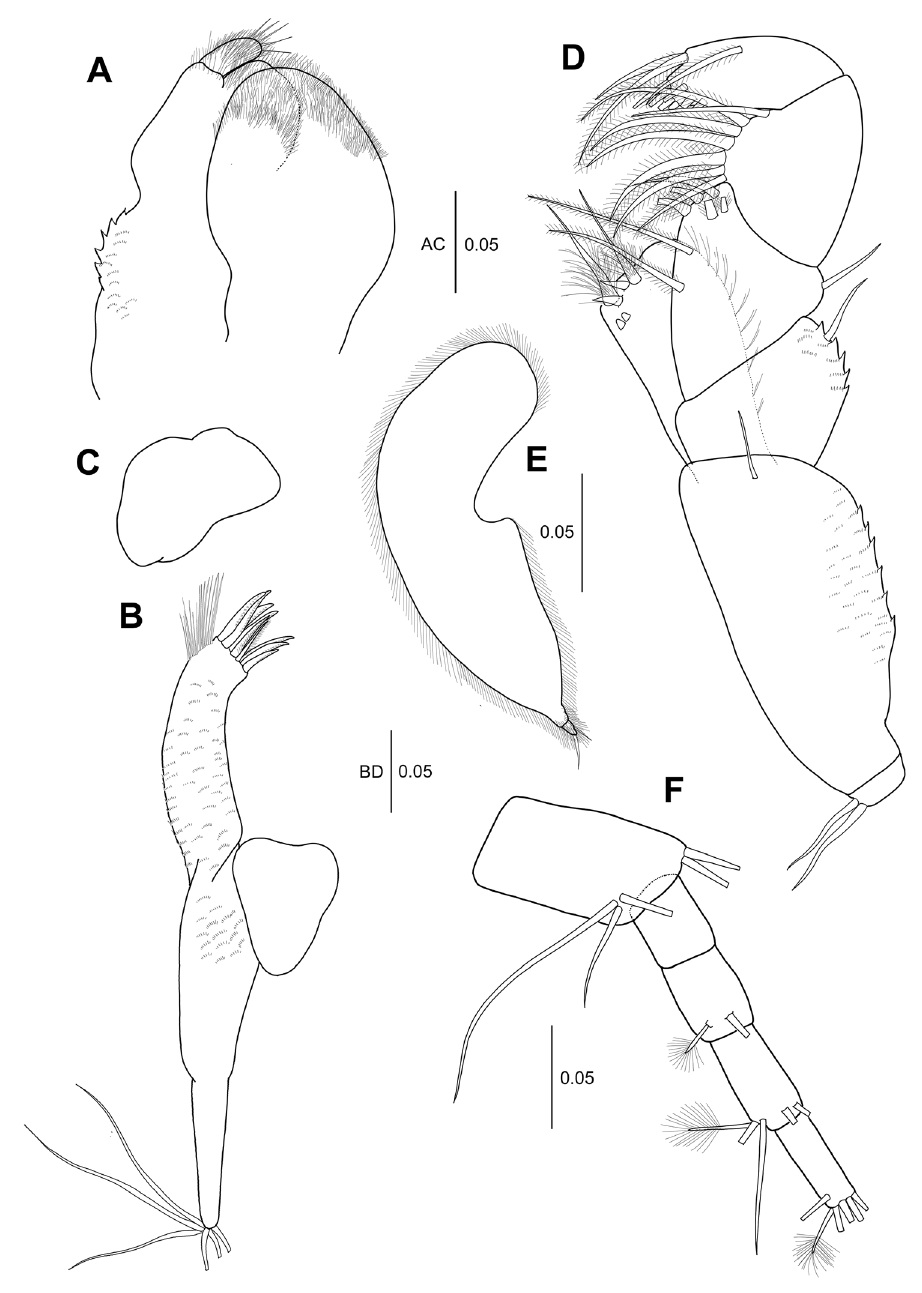
Figure 8. Hexapleomera ulsana sp. n., Jeju population, female, A labium B maxillule C maxilla D maxil- liped E epignath F uropod. Scale bars in